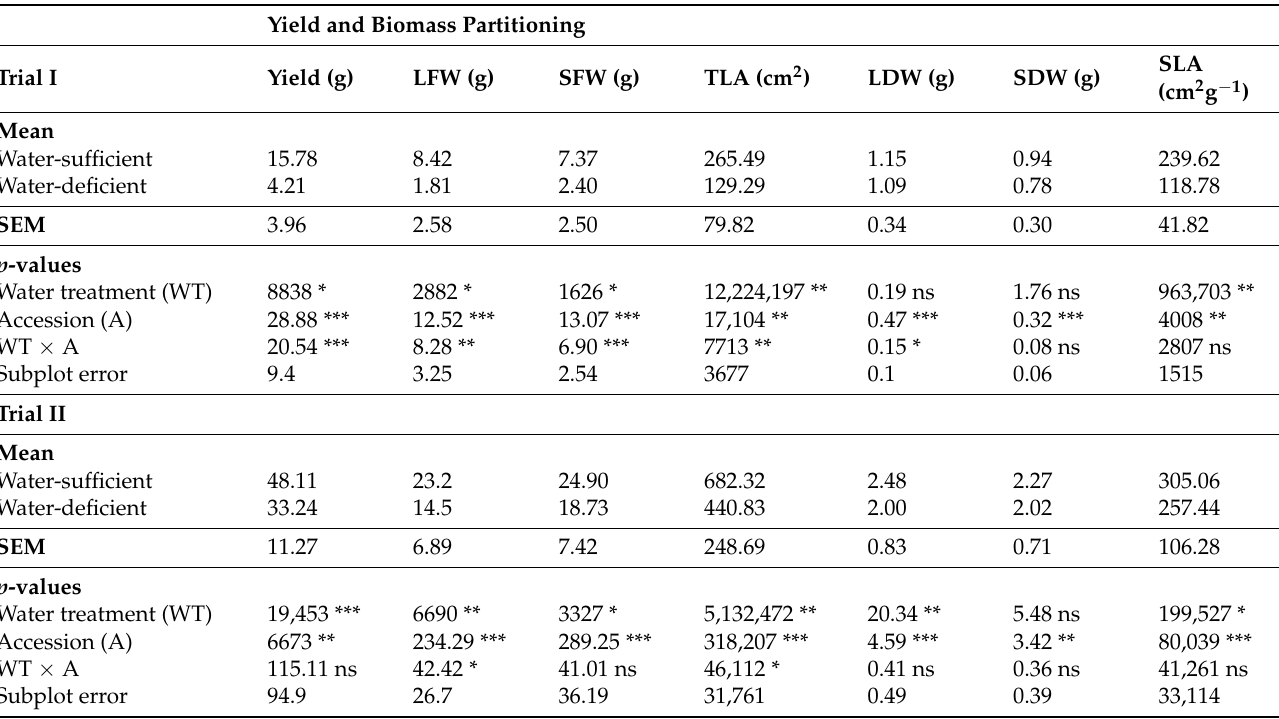
Table 3. Mean and the analysis of variance of water treatment on yield and biomass partitioning: fresh weight of leaf (LFW) and stem (SFW), dry weight of leaf (LDW) and stem (SDW), total leaf area (TLA) and specific leaf area (SLA) in 44 A. tricolor accessions evaluated in Trial I (n = 3) and Trial II (n = 4). Significant difference at p < 0.05, <0.01, <0.001 (*, **, *** respectively) and non-significant